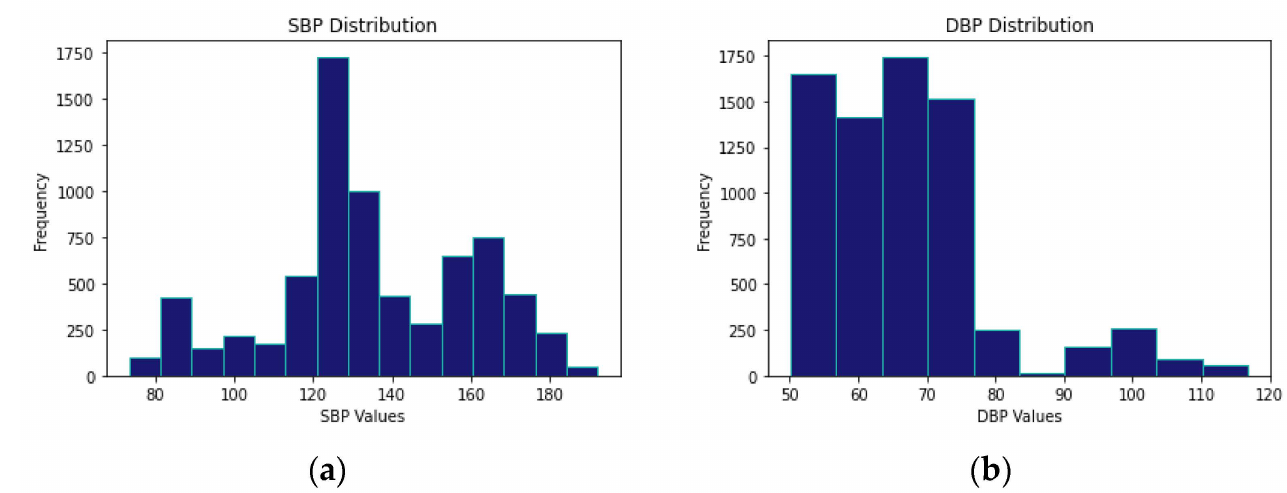
Figure 2. SBP and DBP Values Distribution in the used Dataset. ( a ) SBP Values Distribution. ( b ) DBP Values